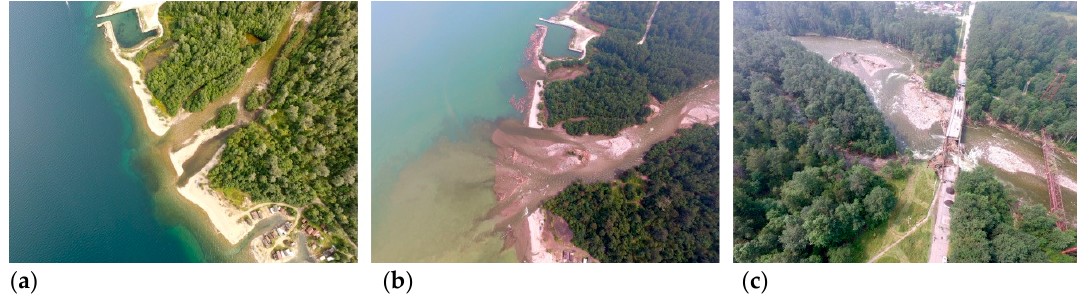
Figure 16. The consequences of the flood on the Solzan river. ( a ), ( b ) channel morphodynamics at the mouth of the river. С oordinates: 51°31 ′ 46.6418 ″ N, 104°9 ′ 27.5627 ″ E. Images was taken: ( a ) August 23, 2017, ( b ) July 31, 2019; ( c ) the destroyed technological bridge. Coordinates: 51°31 ′ 24.6506 ″ N, August 2017, ( b ) 31 July 2019; ( c ) the destroyed technological bridge. Coordinates: 51 ◦ 31 (cid:48) 24.6506 (cid:48)(cid:48) N, 104°9 ′ 43.3299 ″ E. Images was taken on July 31, 2019 104 ◦ 9 (cid:48) 43.3299 (cid:48)(cid:48) E. Images was taken on 31 July